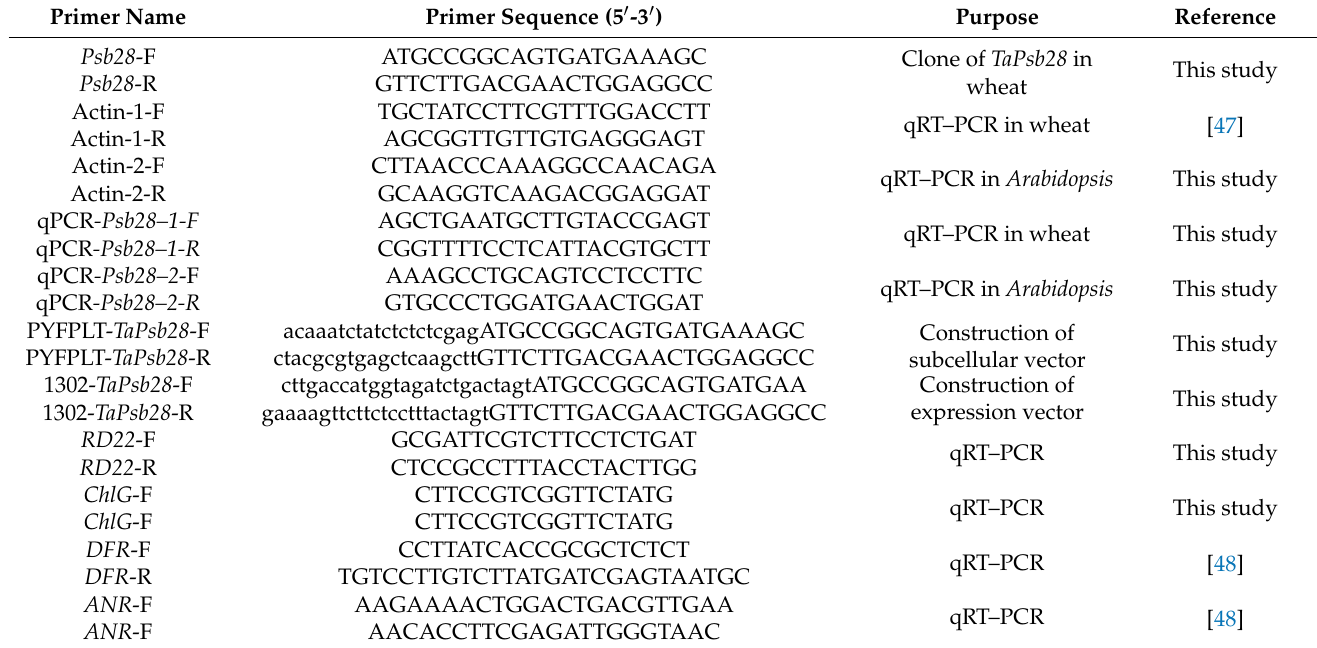
Table 1. List of primers used in this